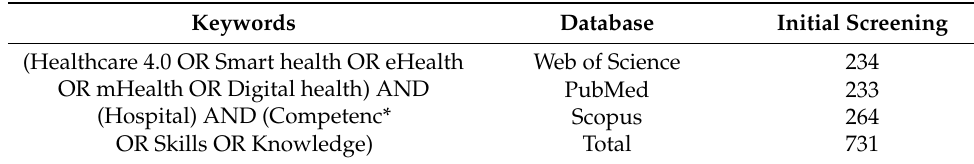
Table 2. Initial search results of the database.